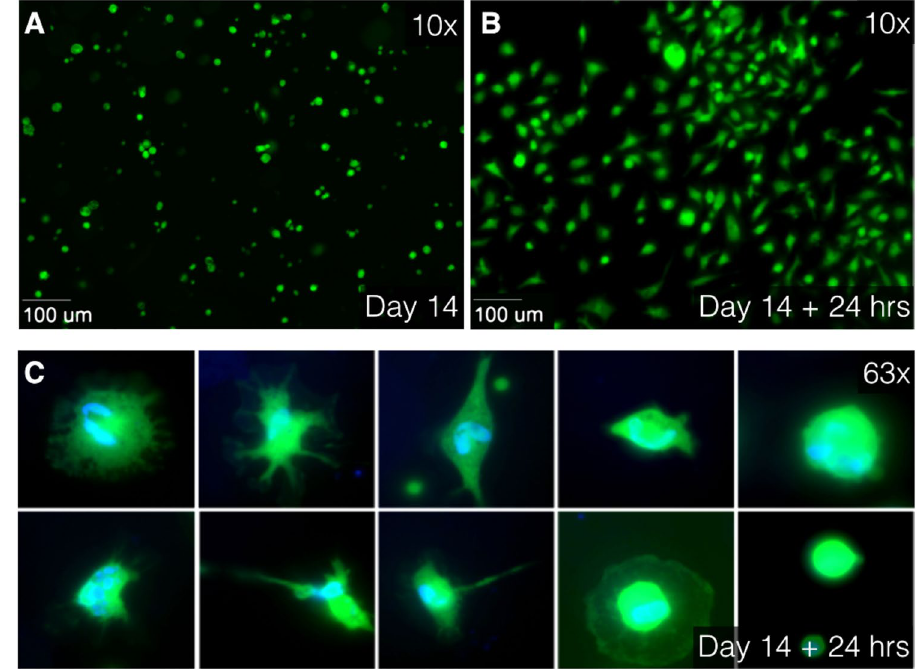
Figure 7. Immunofluorescence images at 10 × ( A , B ) and 63 × oil ( C ) magnification using Zeiss Axiovert 200 M Marianas ™ Microscope. ( A ) After 14 days of culturing, tissues were enzymatically digested using collagenase. Live separate cells, stained with Calcein AM (green), float as round cells in culture medium. ( B) After 24 hours of additional culturing, the cells were attached to the slide. ( C) Different cell type characteristics and differences in cell nuclei are observed in attached cells. Live cytoplasm is stained with Calcein AM (green) and cell nuclei are stained with DAPI (blue). AM indicates acetoxymethyl and DAPI, 4 ′